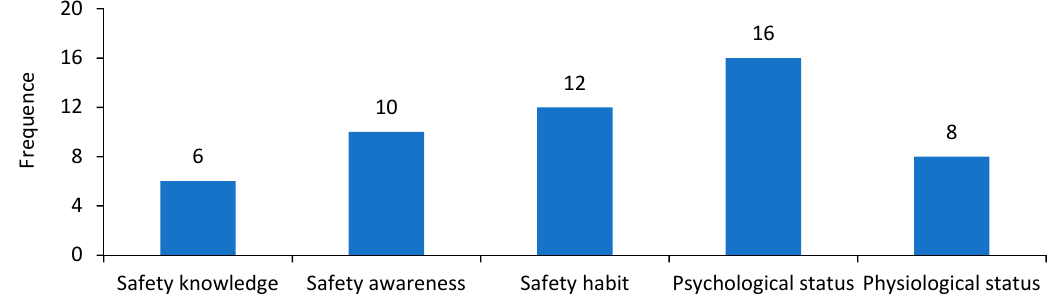
Figure 6. Statistics of unsafe habitual behaviors related to commercial vehicle accidents.